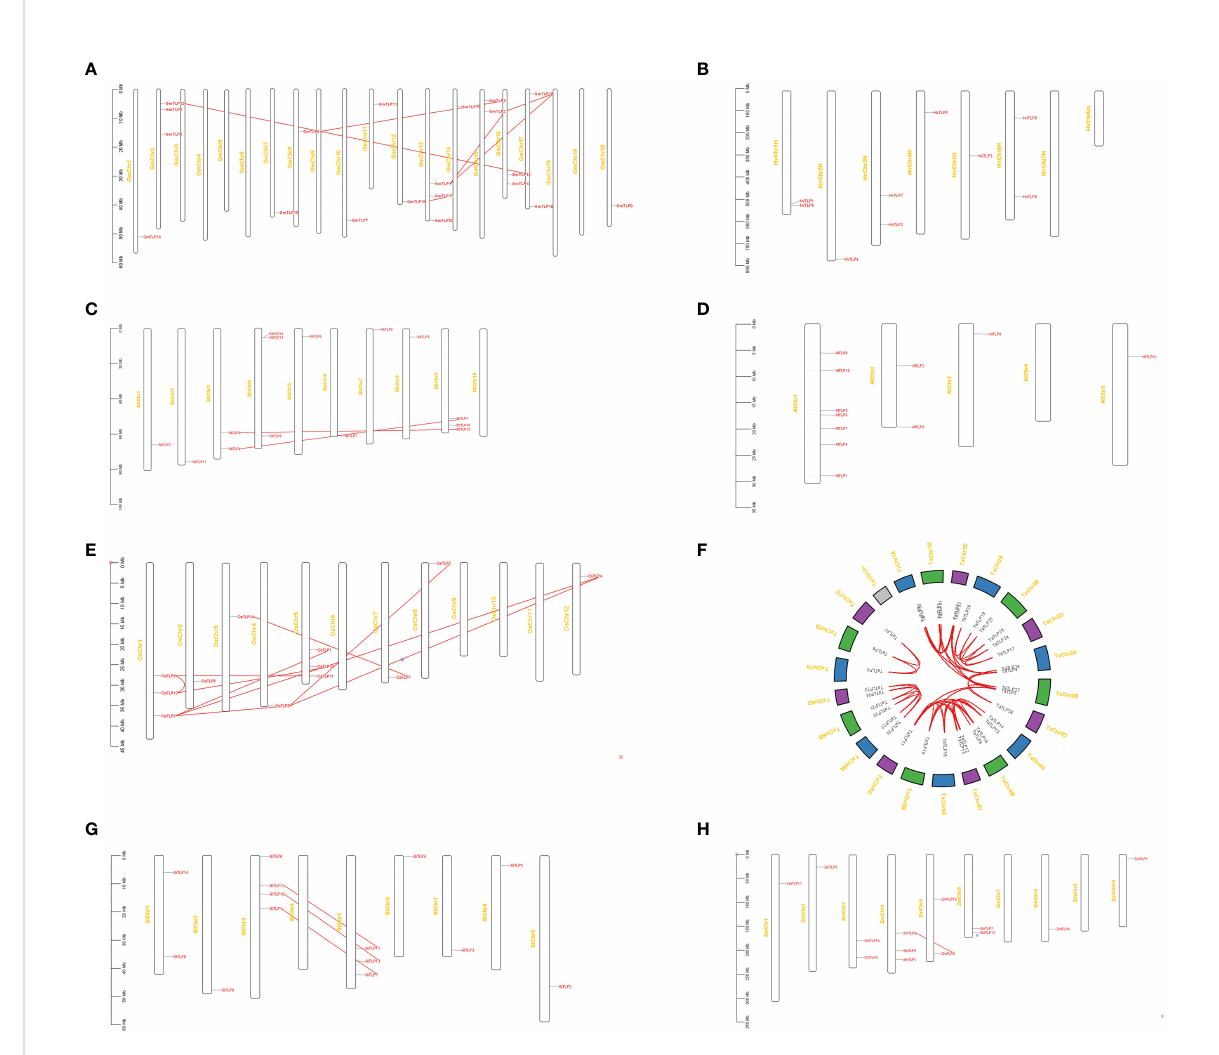
FIGURE 3 The chromosome distribution and duplication analysis of TLP genes in eight species. G.max (A) , H vulgare (B) , S.bicolor (C) , A thaliana (D) , O.sativa (E) , T.aestivum (F) , S.italic (G) , and Z.mays (H) . The red lines showed WGD or segmental